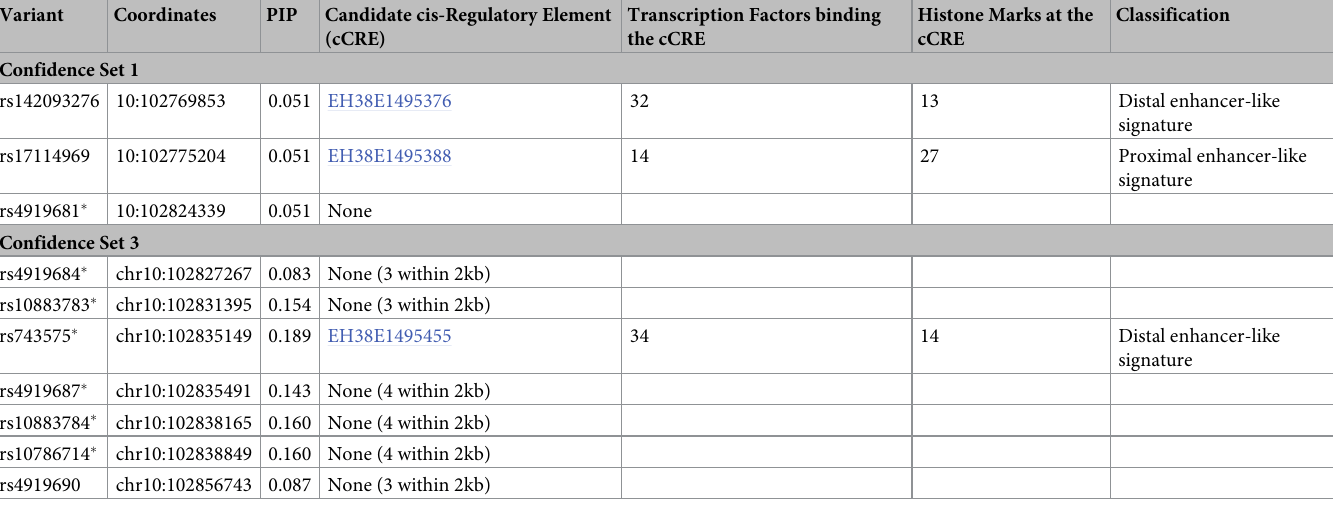
Table 4. In-Silico functional examination of HEALS confidence set variants.